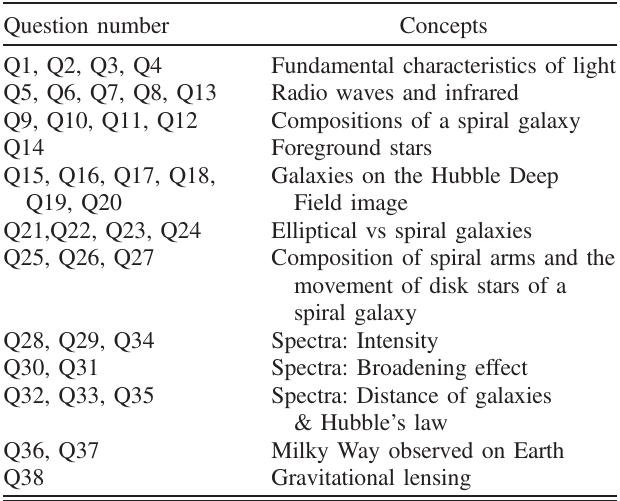
TABLE I. Topics of concept